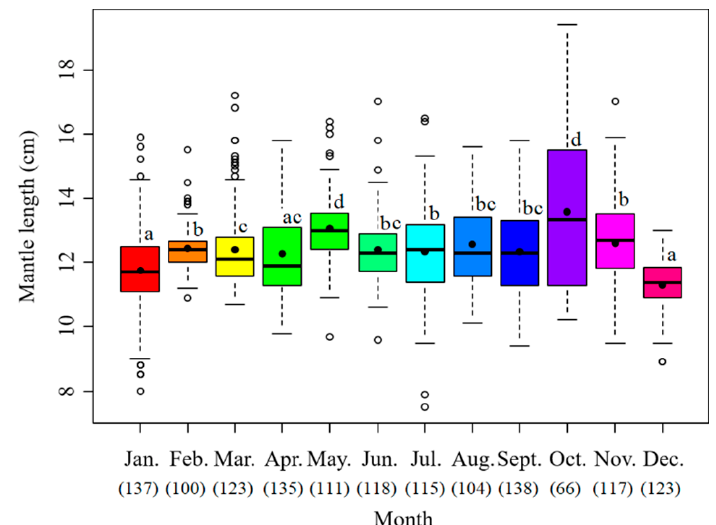
Figure 4. Monthly variation of mantle length of S. oualaniensis . The black points are the mean values; the white points are the outliers; the thick horizontal lines are the medians; the thin horizontal lines are the upper and lower limits; the rectangles contain the middle 50% of the values. The data below the month represent the samples in number. Different letters means significant differences.